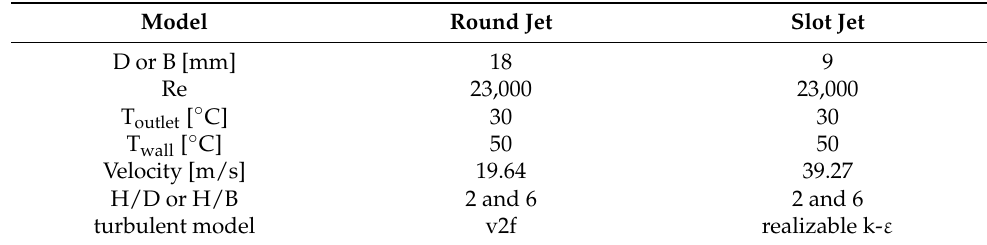
Table 2. Summarizing of the main parameters for the comparison of a slot jet and a round jet.